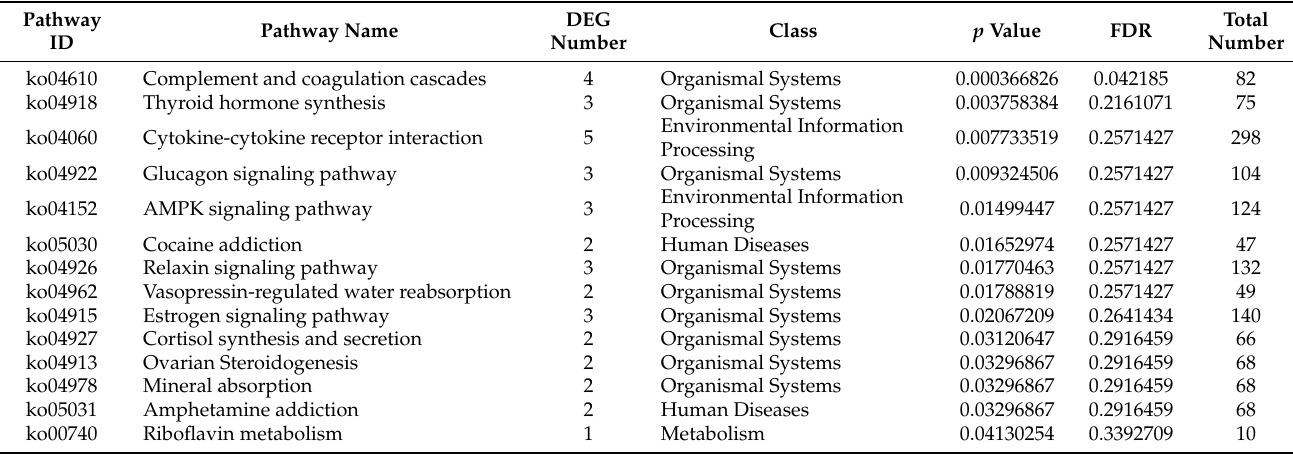
Table A6. KEGG pathways analysis results of DEGs in profile